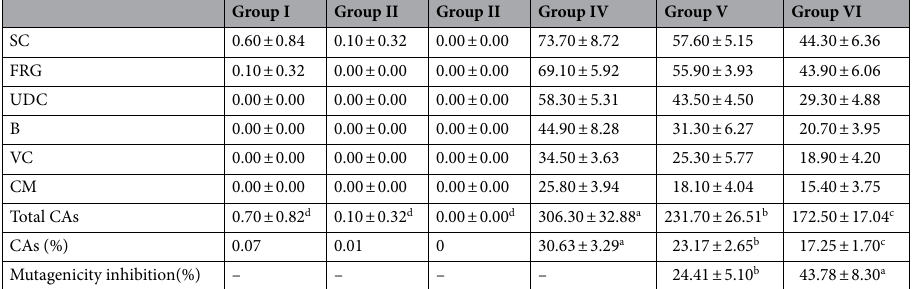
Table 4. Frequencies of chromosomal aberrations (CAs) induced by penoxsulam and the protective role of BBE. Group I: tap water (control), Group II: 25 mg/L BBE, Group III: 50 mg/L BBE, Group IV: 20 μg/L